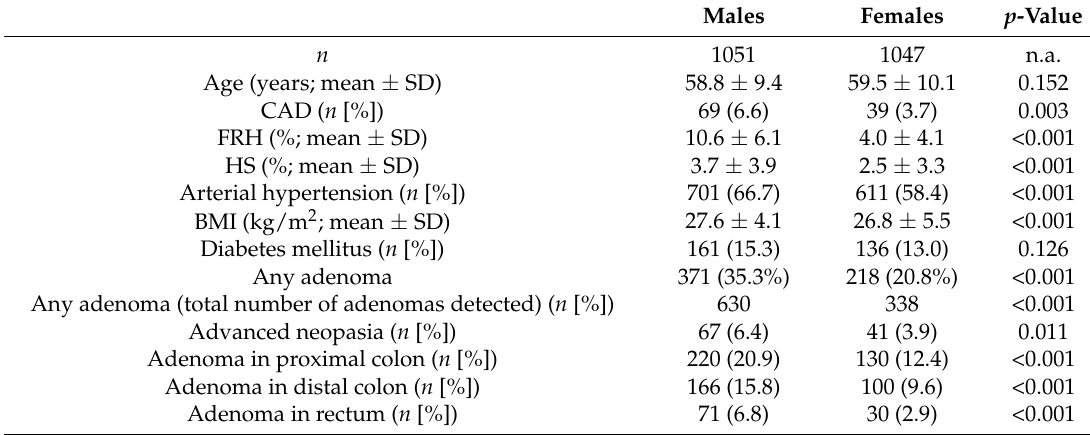
Table 8. Sex-specific differences with regard to cardiovascular risk and location of neoplasia.